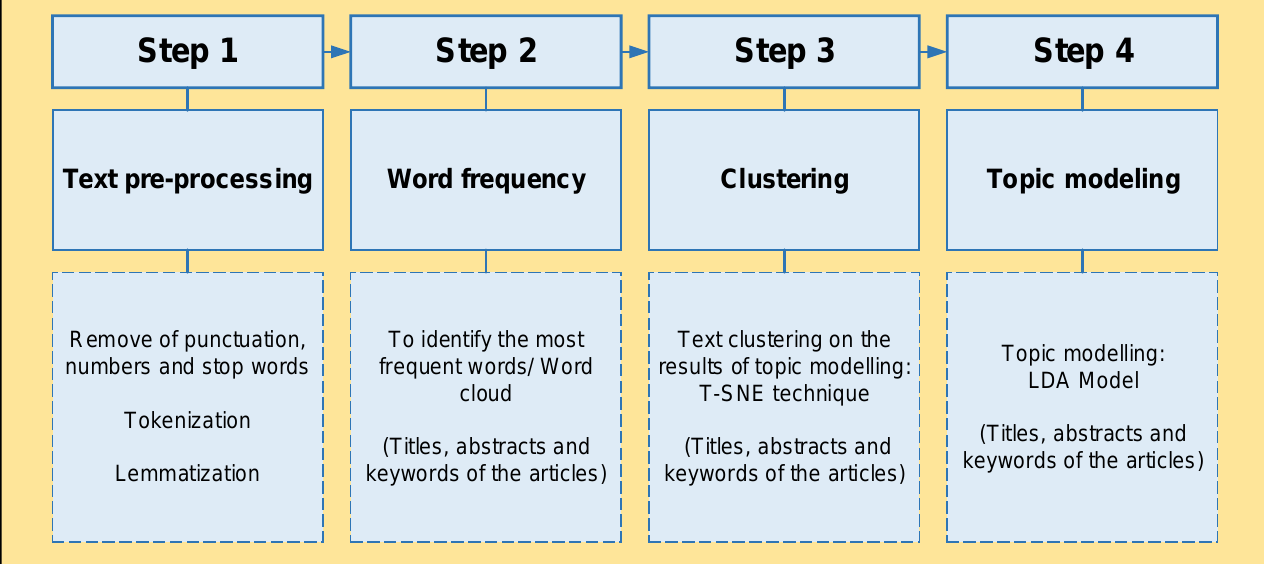
Figure 5. Word Cloud on “Title”.